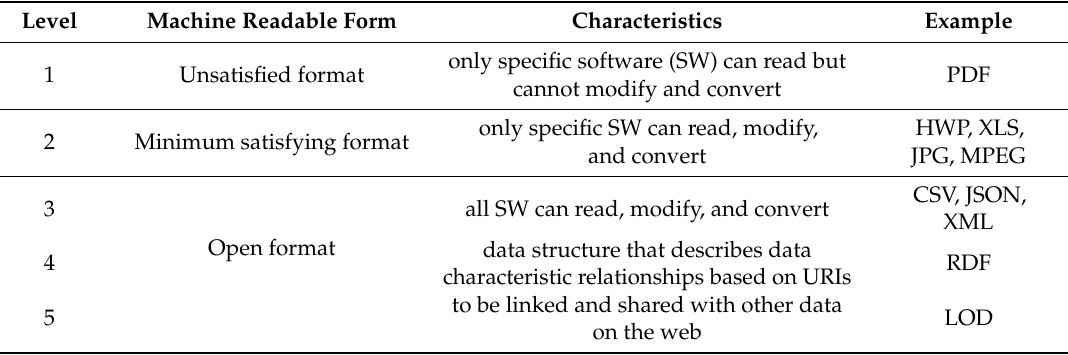
Table 3. Classification of the data